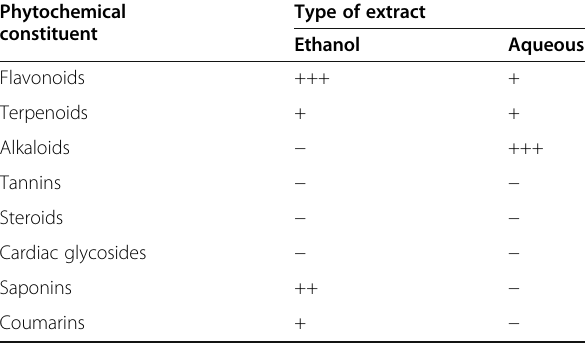
Table 1 Phytochemical screening of S. exigua root extract Phytochemical Type of extract constituent Ethanol Aqueous Flavonoids +++ + Terpenoids +